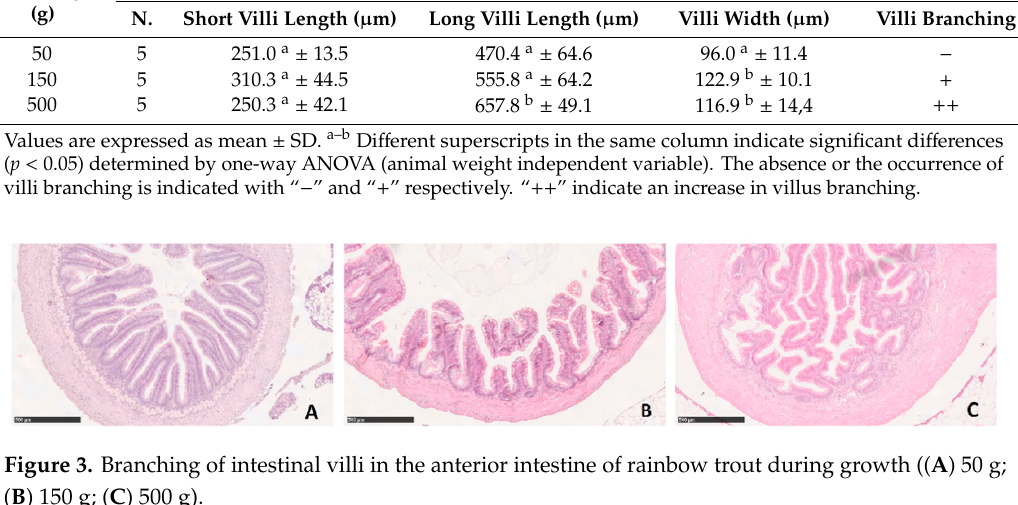
Distal Intestine